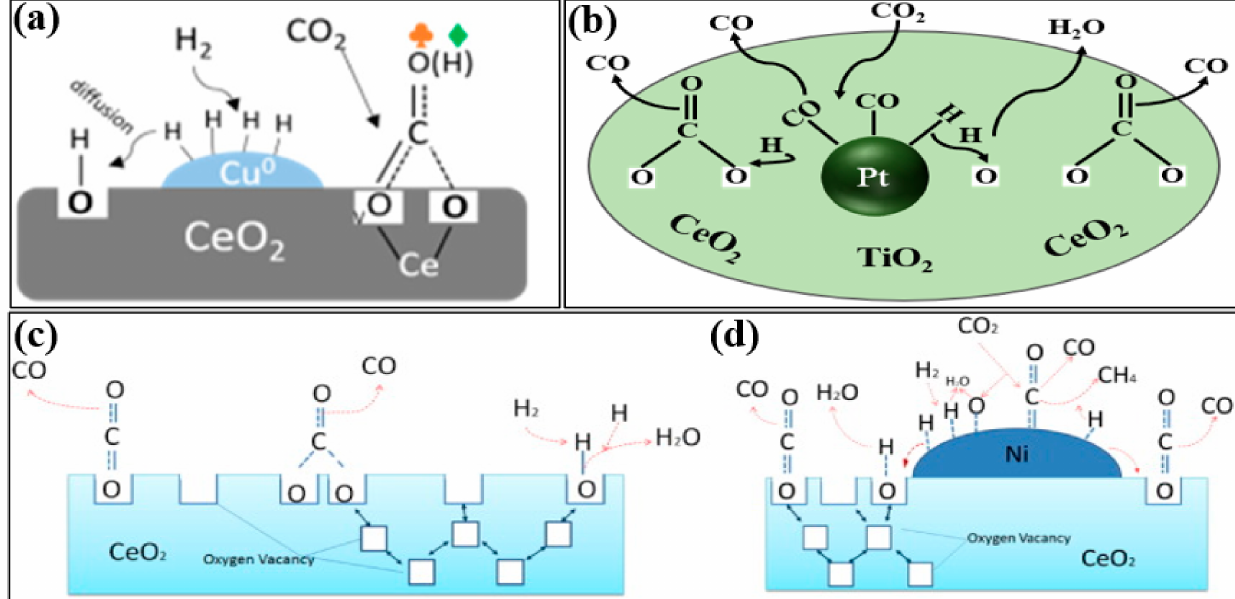
Figure 3. The Redox reaction mechanism of the RWGS reaction over ( a ) Cu-CeO 2 , reprinted with permission from [81]. Copyright ACS, 2018, ( b ) Pt-CeO 2 -TiO 2 , ( c ) ceria nanocube, reprinted with permission from [83]. Elsevier, 2016, and ( d ) Ni-CeO 2 nanocube, reprinted with permission from [83]. Elsevier,